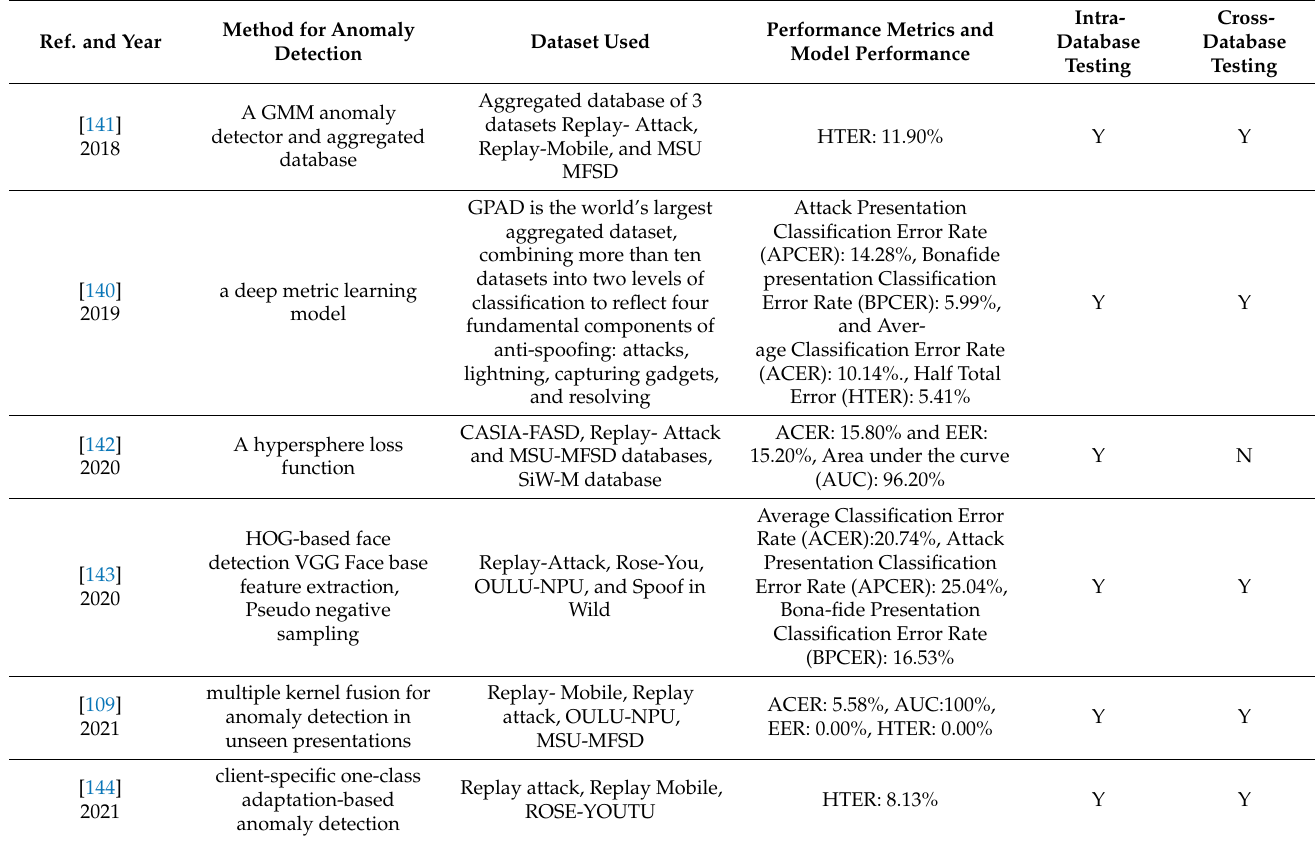
Table 10. Anomaly detection in